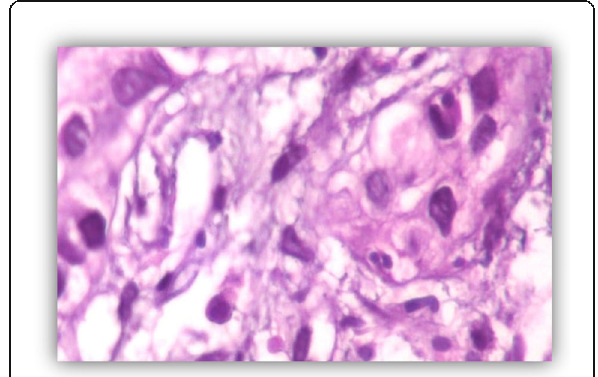
Fig. 3 Imprint cytology for bronchogenic squamous cells